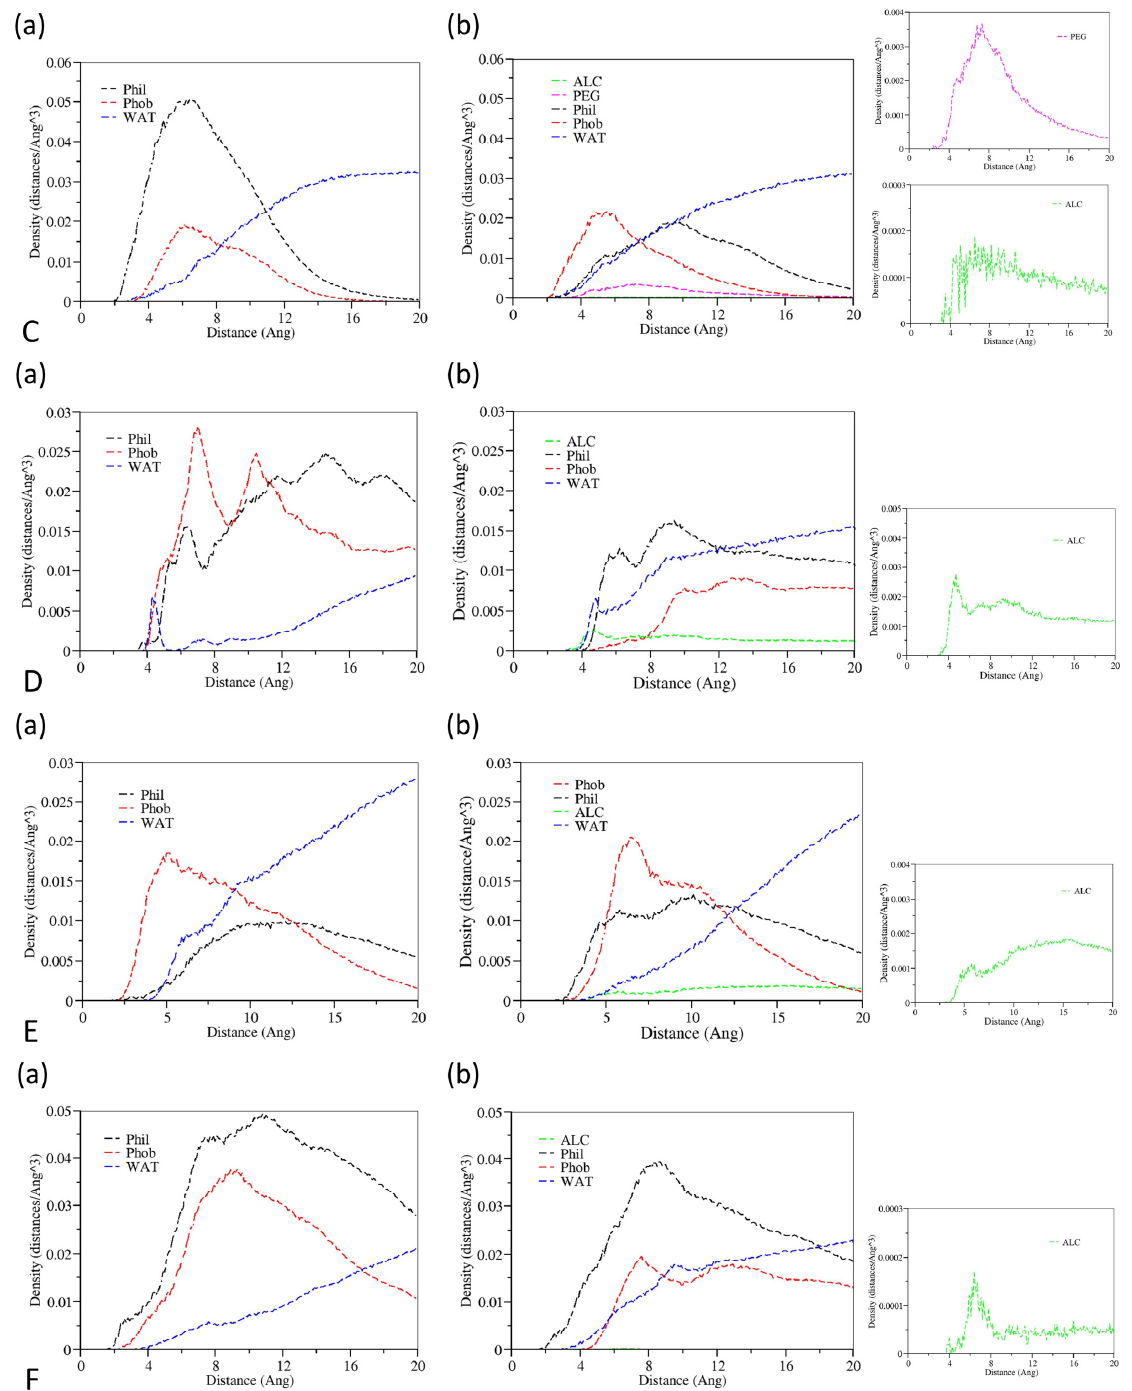
Figure 5. Radial density distributions for various molecular groups against the center of drug particles of ( a ) the formulations without cosolvents and ( b ) the formulations containing cosolvents. ( A ) represents the Cyclosporine system, ( B ) represents the Docetaxel system, ( C ) represents the Etoposide system, ( D ) represents the Paclitaxel system, ( E ) represents the Valrubicin system, and ( F ) represents the Cabazitaxel system. Red represents the hydrophobic groups of the surfactants, black represents the hydrophilic groups of the surfactants, blue represents the water molecules, purple represents the drug molecules, green represents the ethanol molecules, and pink represents PEG 300.